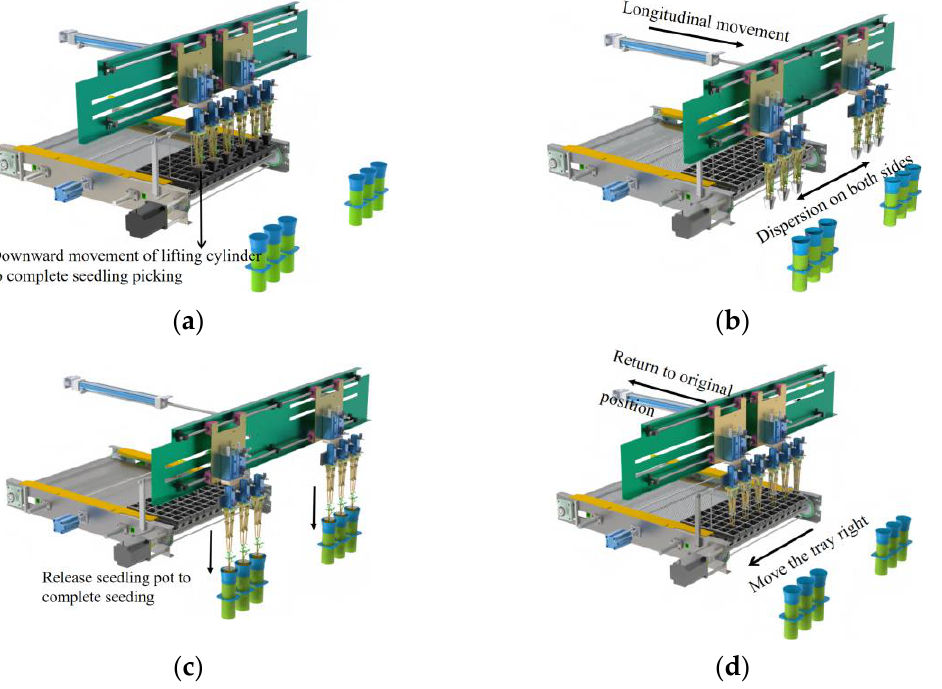
Figure 3. Schematic diagram of the process of picking seedlings: ( a ) Seedling-picking stage; ( b ) con- veying stage from seedling-picking position to seedling-throwing position; ( c ) the stage of seedling- throwing pot; ( d ) reduction process.